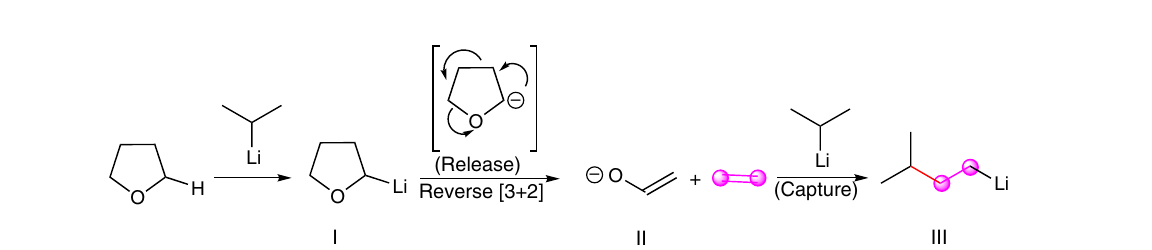
Figure 4 | Possible pathway of release-capture ethylene. ( I ) 2-LithioTHF. ( II ) Lithium enolate. ( III ) Doubly homologated of isopropyllithium to generate the isopentyllithium in situ